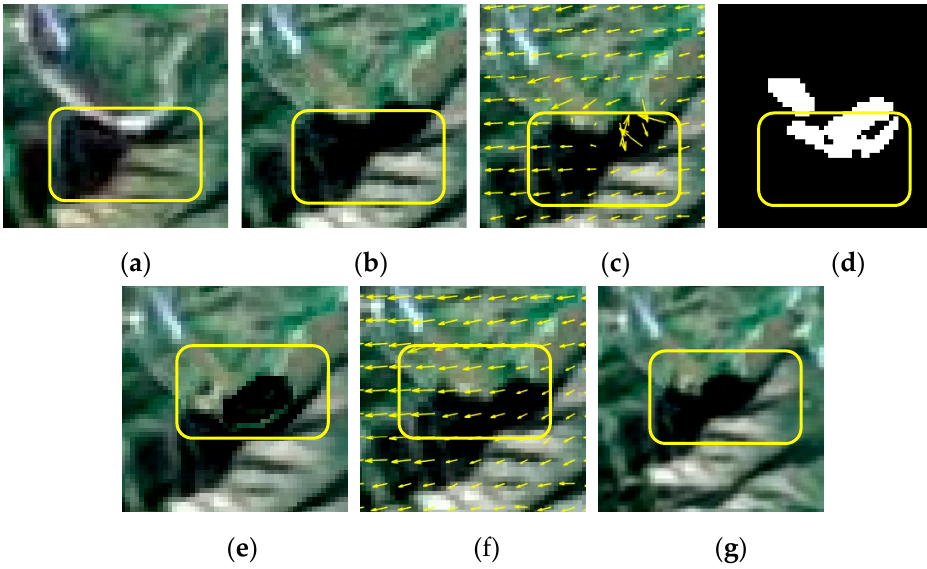
Figure 4. The abnormal displacements correction. ( a ) Reference image, ( b ) sensed image, ( c ) the displacement field by Equation (6), ( d ) the mask for abnormal displacements, ( e ) the BOF aligned image, ( f ) the corrected displacements, ( g ) the aligned image after abnormal displacements correc- tion.